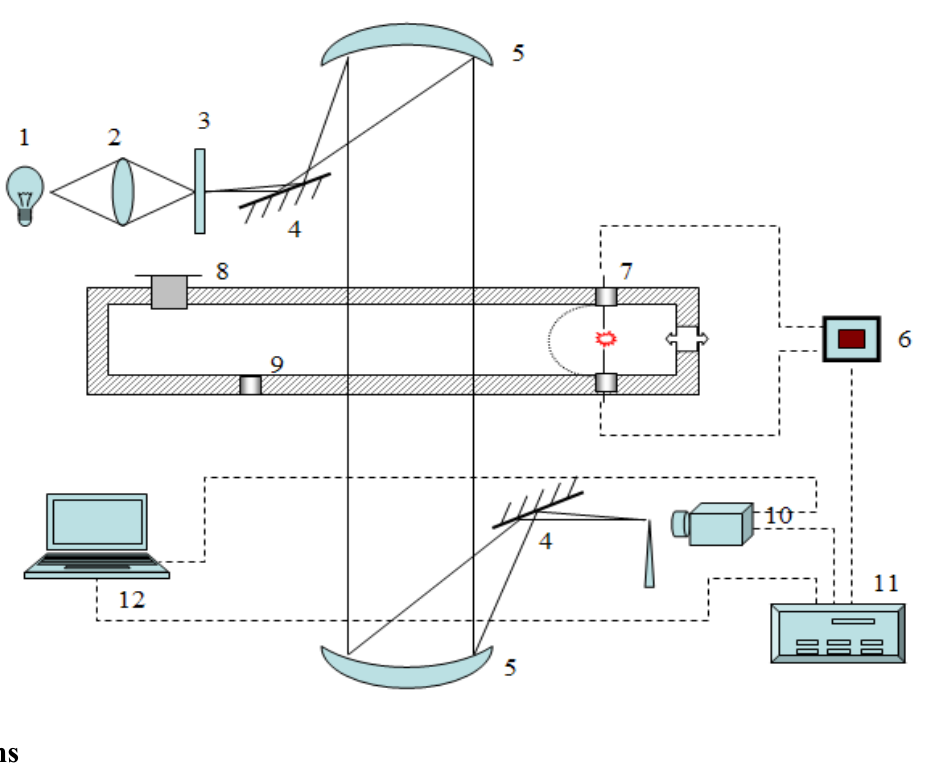
Figure 6. Sketch of gas explosive experiment system: ( 1 ) halogen tungsten lamp; ( 2 ) convex lens; ( 3 ) slit; ( 4 ) reflecting mirror; ( 5 ) concave mirror; ( 6 ) spark igniter; ( 7 ) ignition electrode; ( 8 ) discharge vent; ( 9 ) pressure sensor; ( 10 ) high speed video camera; ( 11 ) synchronization controller; ( 12 )